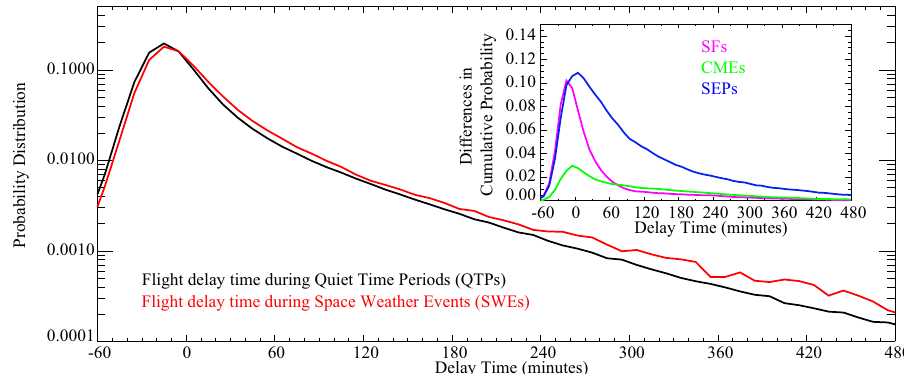
Figure 2. Probability distributions of flight arrival delays during SWEs (red) and quiet time periods (blue) averaged over 5 airports. The inner panel shows the differences in cumulative distributions between SWEs (SFs: purple, CMEs: green, SEPs: blue) and quiet time periods.